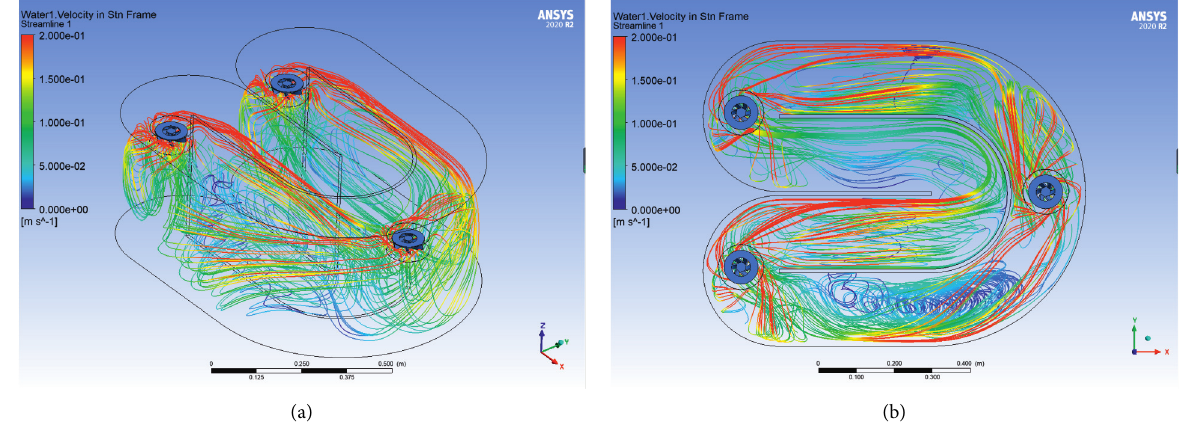
Figure 7: Flow charts at different